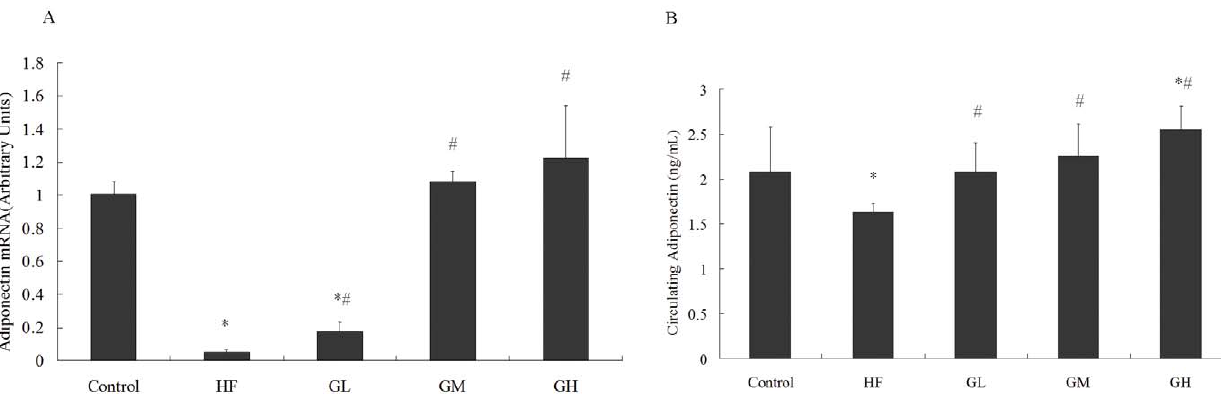
Figure 2. GTPs alleviates the decrease of adiponectin expression in fat tissue and serum induced by HF diet. Fig. 2 A showed the mRNA level of adiponectin in adipose tissue, the result is presented in arbitrary units using GADPH as reference. Fig. 2 B presented the levels of serum adiponectin. The HF group exhibited significantly reduced mRNA and circulating levels of adiponectin, the decreased expressions were attenuated by GTPs treatment at different concentrations (GL 0.8 g/L, GM 1.6 g/L, GH 3.2 g/L.) (* P , 0.05 vs. the control; # P , .05 vs. the HF group). Data is expressed as Mean 6 SEM (N=6).